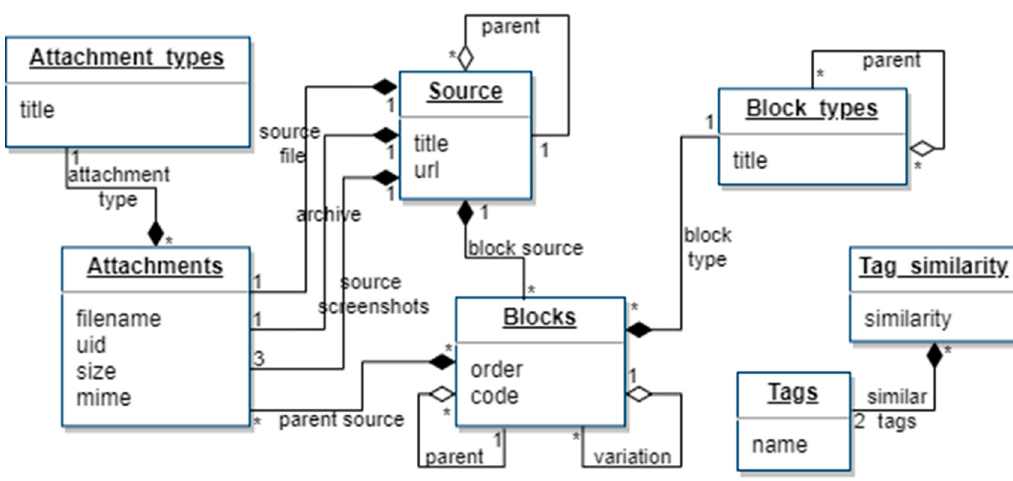
Figure 2. Dataset data structure simplified diagram.